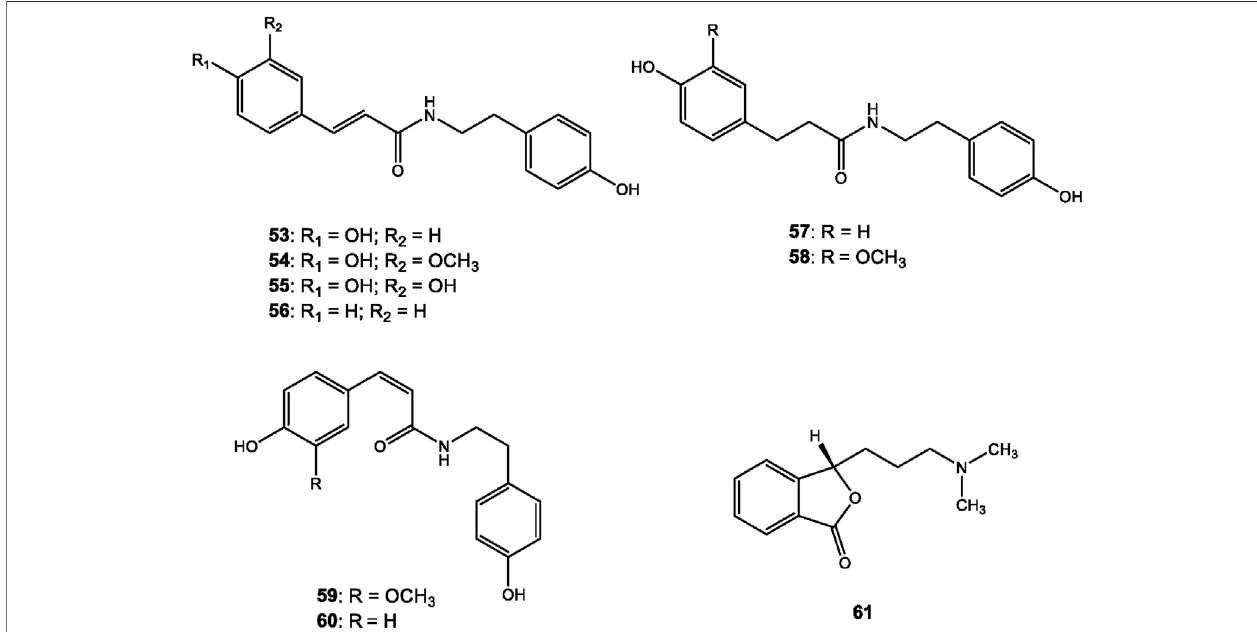
FIGURE 4 | Structures of organic amine alkaloids reported in Dendrobium .